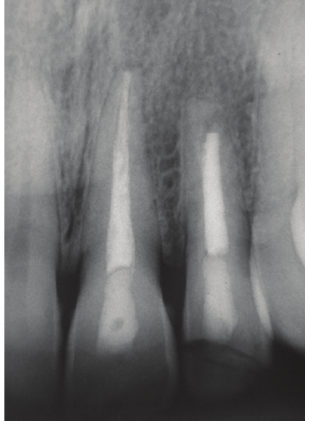
Figure 7: Radiograph showing the long-term success of apexifica- tion and root canal treatment of tooth 22 after fourteen and half years of follow-up and root canal treatment of tooth 21 after fifteen and half years (October 2013).